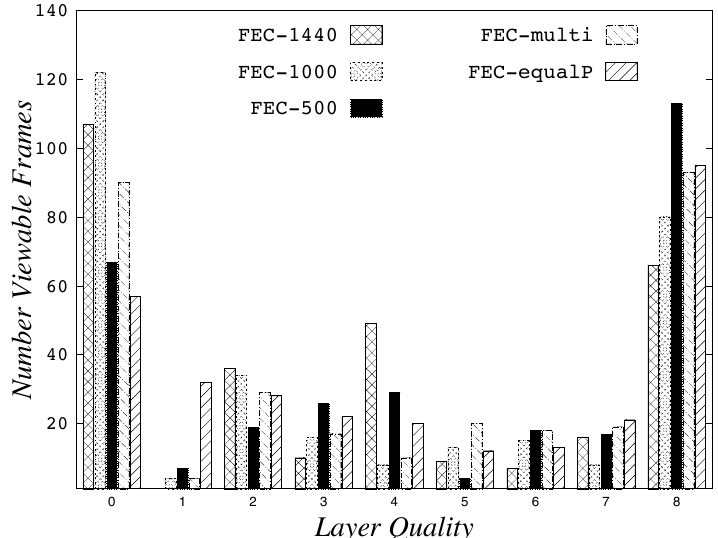
Figure A3. Example of the number of viewable layers for SVC-SC, for each of the FECPacket thres , at a packet loss rate of 10%.